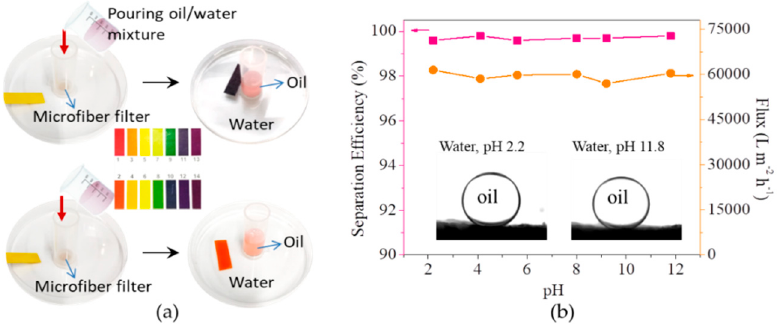
Figure 5. ( a ) Filtration of strong acid/base-based water/oil mixtures; ( b ) Separation efficiencies and fluxes of microfiber filters as a function of pH of water/oil mixtures (Inset shows the oil (1,2-dichloroethane) contact angles on microfiber filters in water at pH 2.2 and pH 11.8).